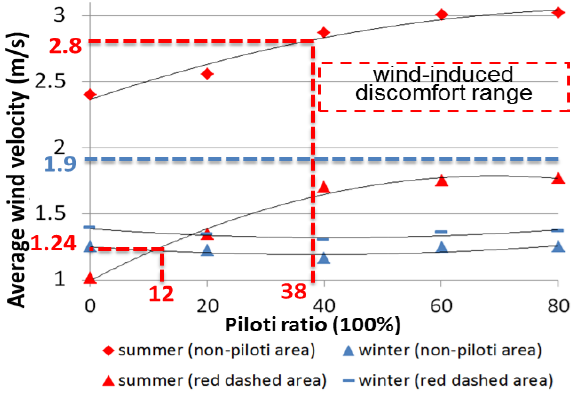
Figure 12. The relationship between the piloti ratio and the average wind velocity of non-piloti areas.